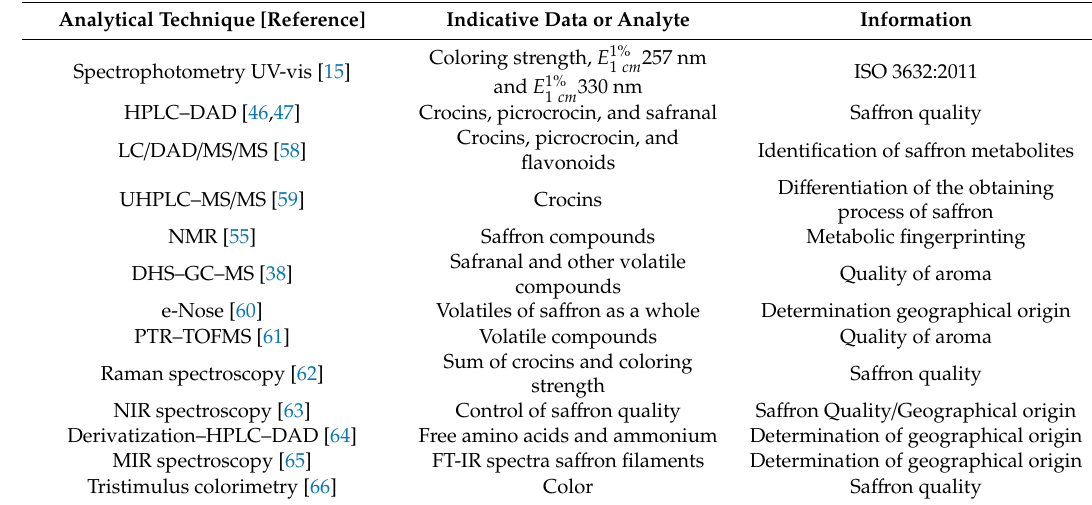
Table 1. Analytical techniques for sa ff ron